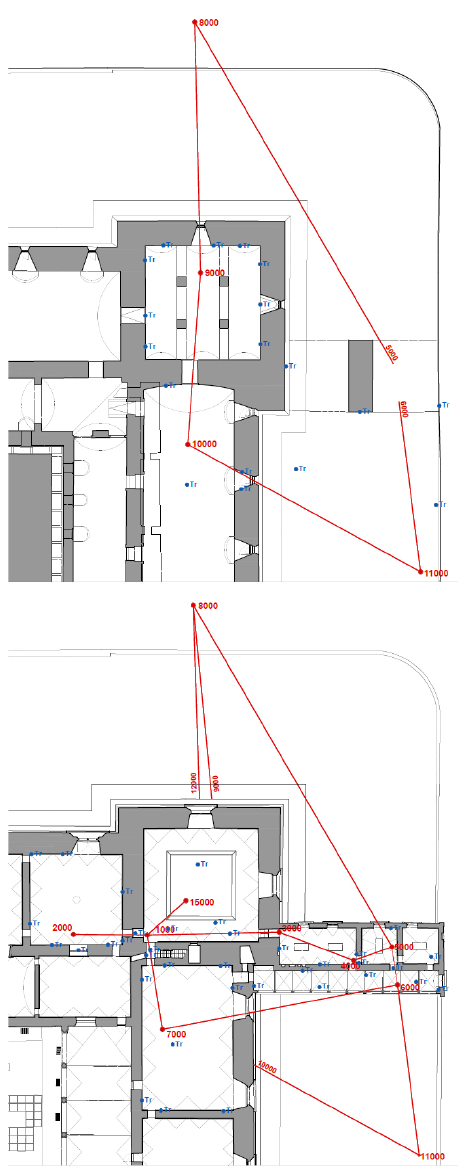
Figure 1. Topographic network of two different levels (ground and Sala delle Asse